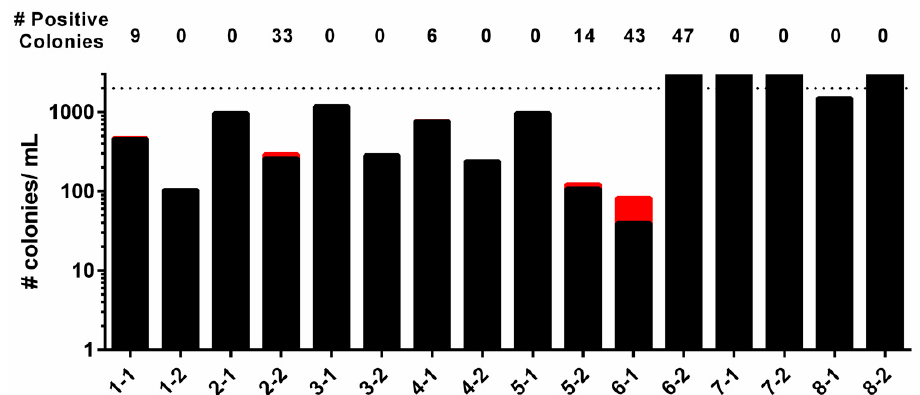
Figure 2. E ffi ciency of allelic replacement of NewSweet Janus in TIGR4S varied by isolated colony. Eight isolated colonies were selected from the transformation generating TIGR4S, followed by selection of two isolated colonies from each transformation generating TIGR4S ∆ cps::NewSweetJanus from the eight TIGR4S colonies. The colony numbers are listed as first transformation-second transformation. For example, “1-1” represents the first TIGR4S ∆ cps::NewSweetJanus colony in TIGR4S clone #1 and “2-1” represents the first TIGR4S ∆ cps::NewSweetJanus colony in TIGR4S clone #2. The sixteen colonies of TIGR4S ∆ cps::NewSweetJanus were transformed with D39 genomic DNA. The number of true-positive colonies (red bars, number above column) and the number of false-positive colonies (black bars) were determined per mL of transformation. Dashed line represents upper limit of detection. To confirm that this initial selection yields a clone that is more e ffi cient at recombining the desired allelic replacement (in this study-capsule), we utilized the TIGR4S ∆ cps::NewSweetJanus clone that Table 6. Ratio of true positive to false positive colonies. Selection occurred on 800 µg/mL streptomycin had the highest true-positive / false-positive ratio (#6-1) to create capsule swap variants. While the original Sweet Janus and NewSweet Janus capsule deletion clones in our TIGR4 were ine ff ective at recombining capsule (Figure 1), TIGR4S ∆ cps::NewSweetJanus clone #6-1 had a high e ffi ciency at recombining capsule, with correct allelic replacement occurring for seven of 13 capsule types on the first transformation attempt and 3 more on the second transformation attempt (Figure 3a, Table 7). To further confirm that vetting the transformation strain streamlines further allelic replacement, we identified a clone of D39S ∆ cps::NewSweetJanus that had a high true-positive / false-positive ratio and subjected it to transformation with genomic DNA from 13 di ff erent serotypes, with correct allelic replacement occurring for 11 of 13 capsule types (Figure 3b).